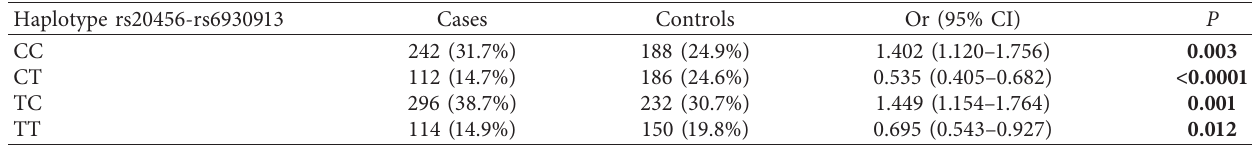
Table 5: Haplotypes of KIF6 gene in cases and